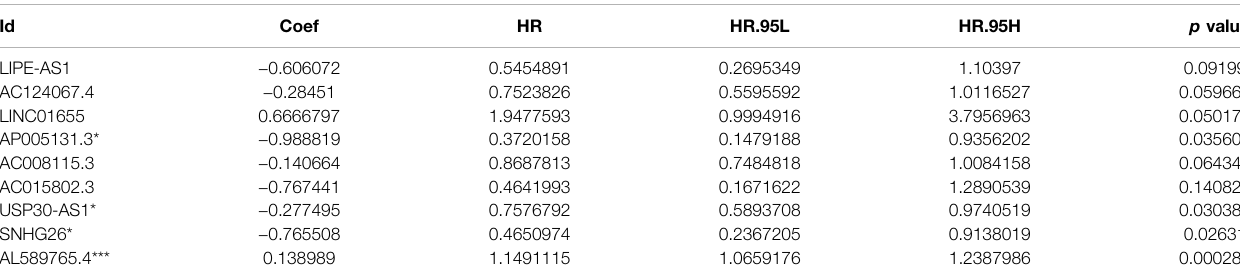
TABLE 2 | Amino acid metabolism-related lncRNA-based prognostic signature. Id